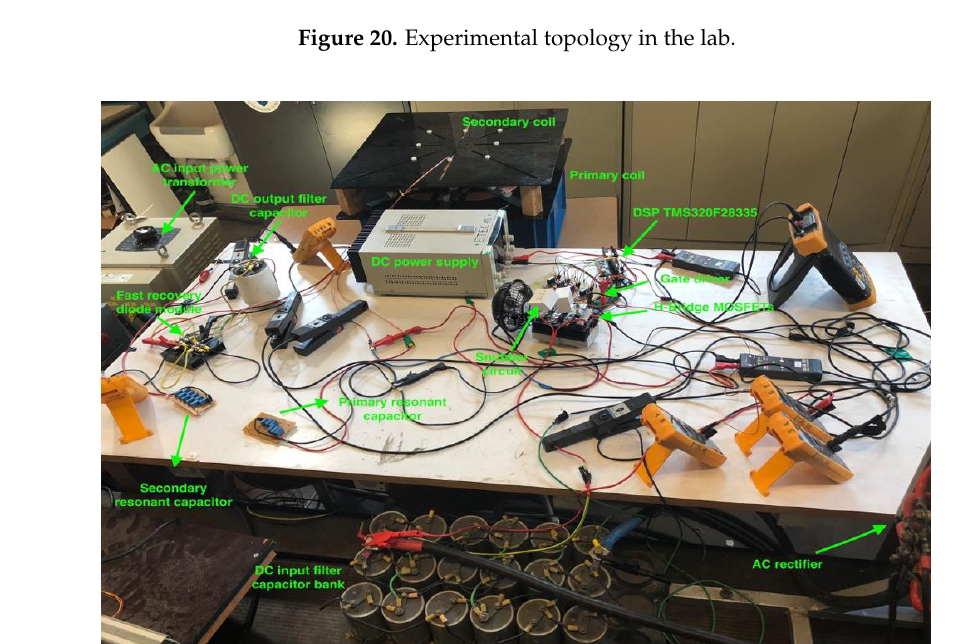
Table 5. Components used in the prototype.